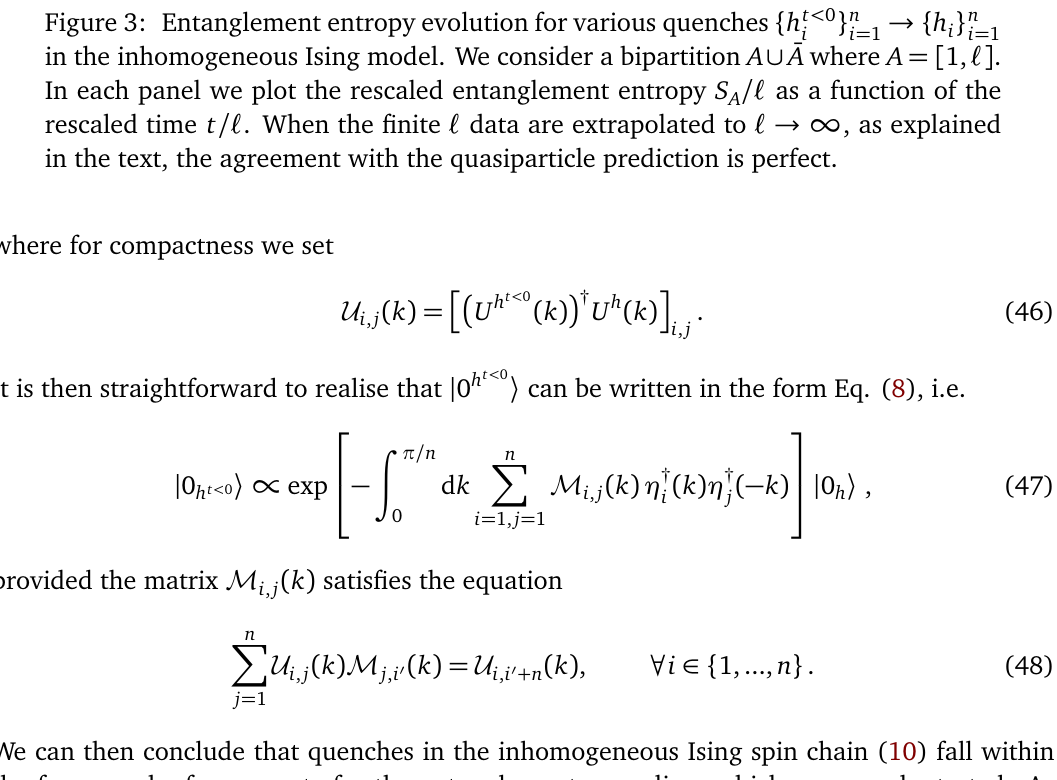
} n → { h } n i i i = 1 i = 1 /(cid:96) as a function of the A